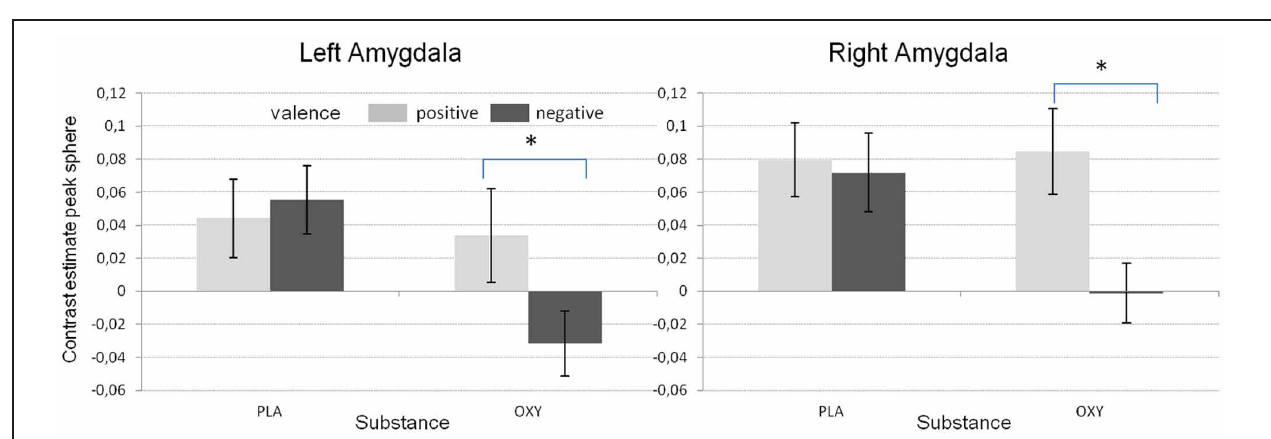
FIGURE 3 | Mean contrast estimates for the region of interest (amygdala peak voxel from the SPM model + 5mm sphere) for the contrast “social > non-social” in the left and right amygdala reflecting the three-way interaction between CD38, COMT, and the